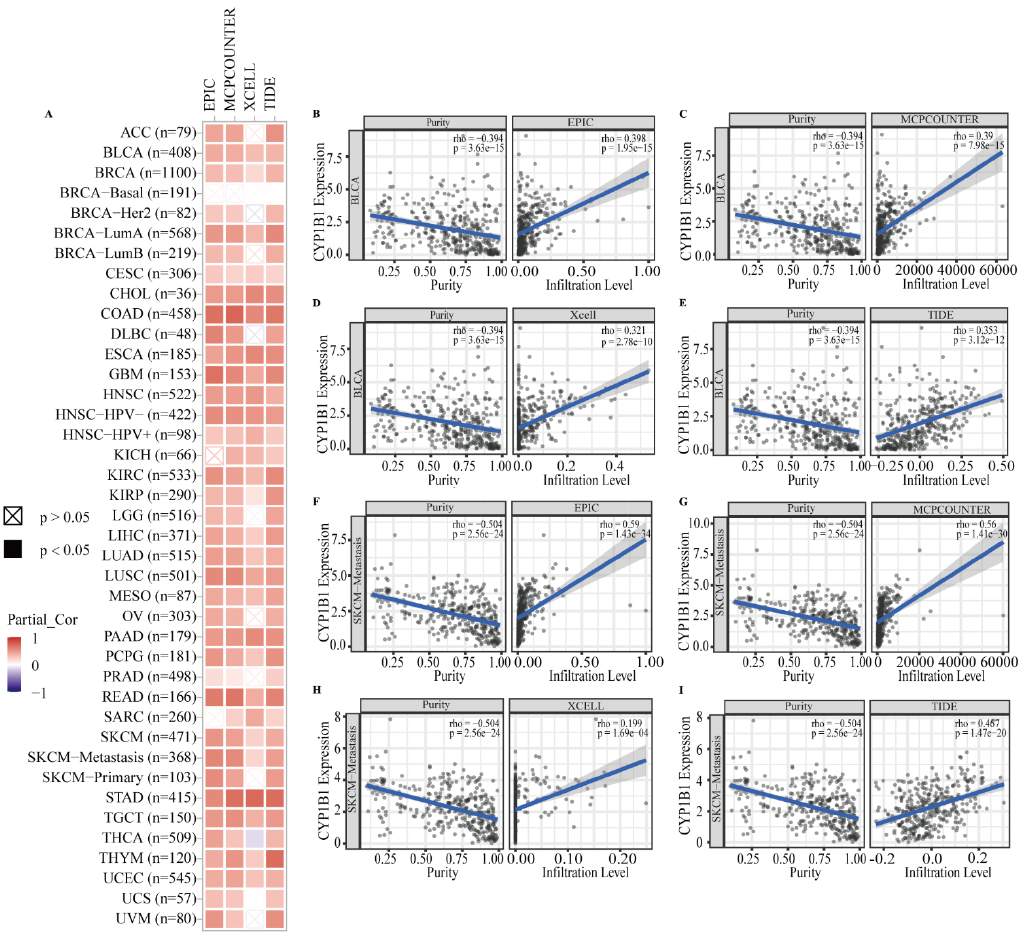
Figure 3. The correlations between CYP1B1 expression and immune infiltration of cancer-associated fibroblasts. ( A ) The correlation between CYP1B1 expression and CAFs infiltration estimated by the EPIC, MCPCOUNTER, XCELL, and TIDE algorithm in cancer. ( B – E ) The correlation between CYP1B1 expression and CAFs infiltration estimated by the EPIC ( B ), MCPCOUNTER ( C ), XCELL ( D ), and TIDE ( E ) algorithm in BRCA. ( F – I ) The correlation between CYP1B1 expression and CAFs infiltration estimated by the EPIC ( F ), MCPCOUNTER ( G ), XCELL ( H ), and TIDE ( I ) algorithm in SKCM-Metastasis.